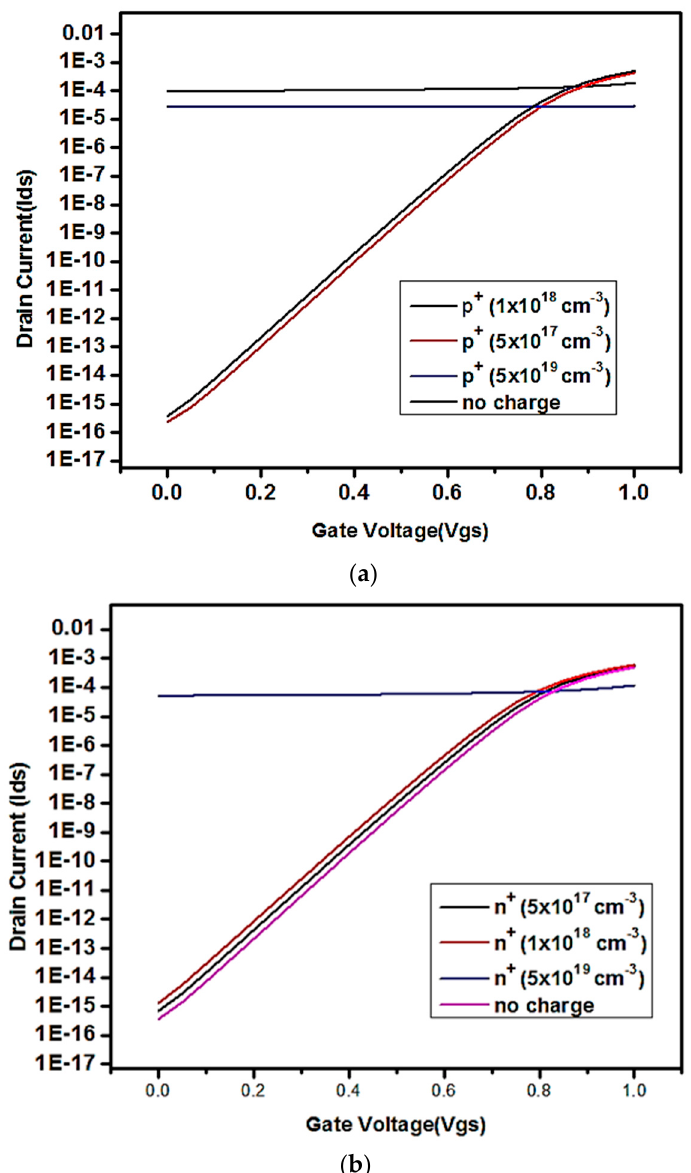
Figure 7. ( a ) Graph representing drain current versus gate voltage of the proposed n + pocket AJ DG MOSFET for p + charge concentration in the cavity region; ( b ) Graph representing drain current versus gate voltage of the proposed n + pocket AJ DG MOSFET for n + charge concentration in the cavity region.